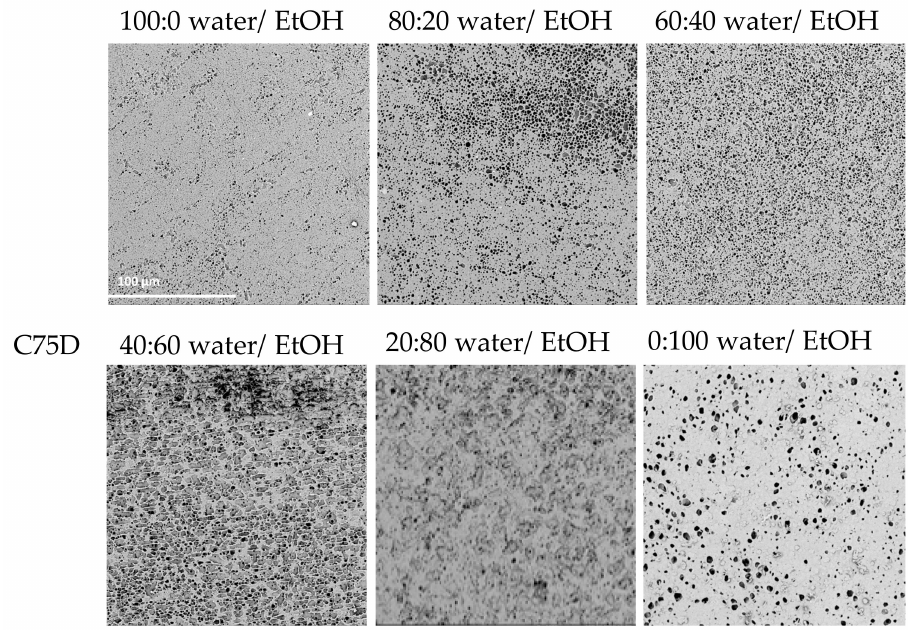
Figure 3. Morphology of internal surface of cylindrical scaffolds obtained from ChronoFlex C75D for different nonsolvent compositions; scale bar: 100 µ m.